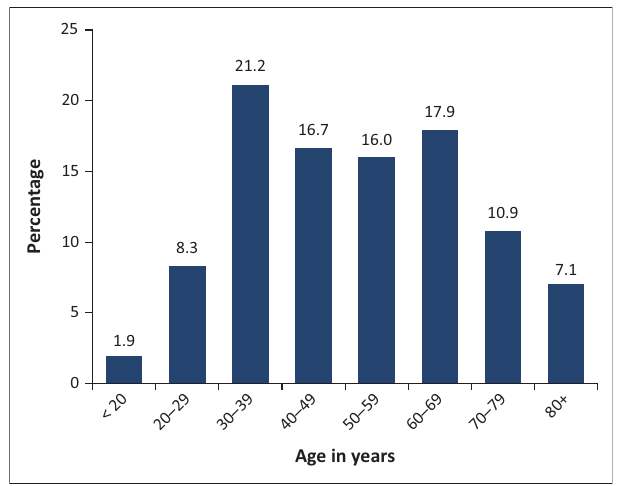
FIGURE 1 : Distribution of age in patients with venous